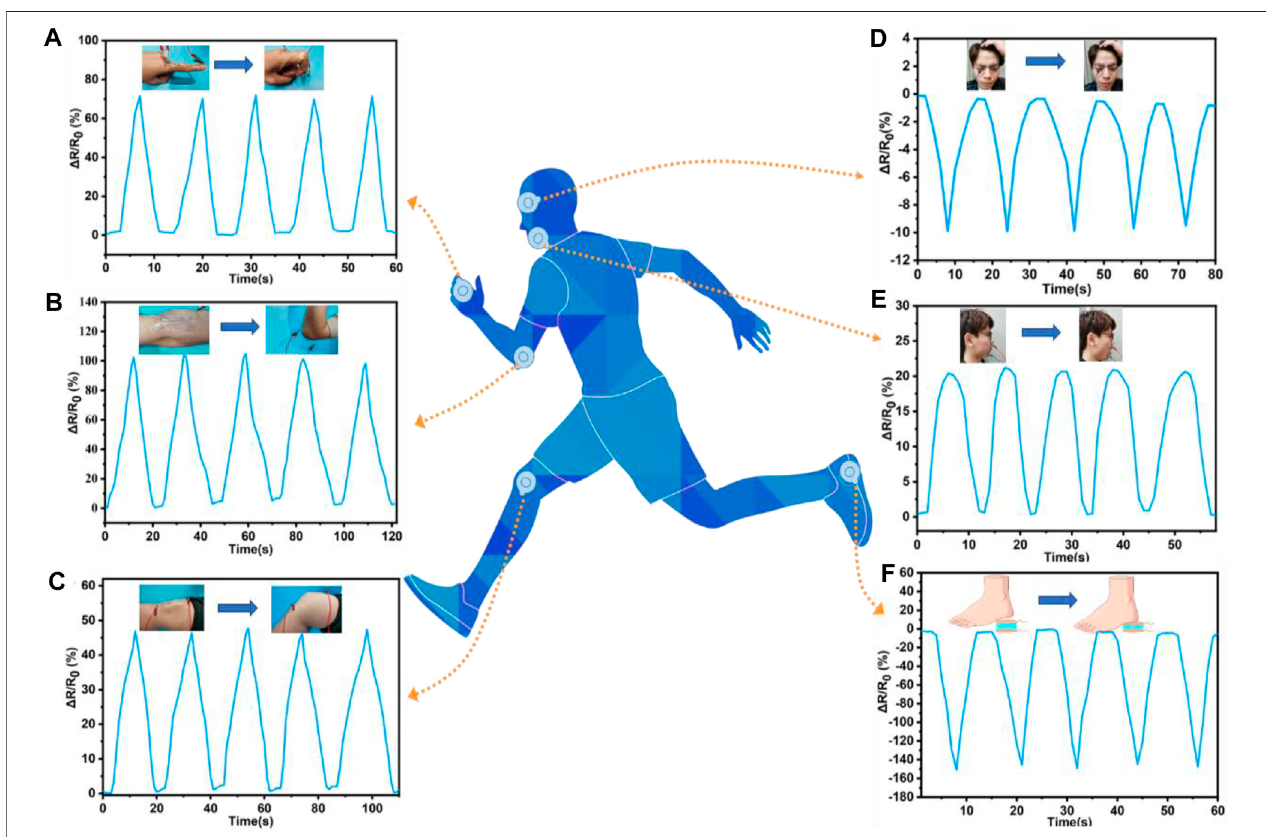
FIGURE 7 | The real-time monitoring of human motions with ADN 1.5 hydrogel-based strain sensors. The real-time monitoring of large-range human motions with fi nger (A) , elbow (B) , knee (C) . The real-time monitoring of tiny human motions: frown (D) , mouth movement (E) , and (F) foot planter pressure during locomotion.